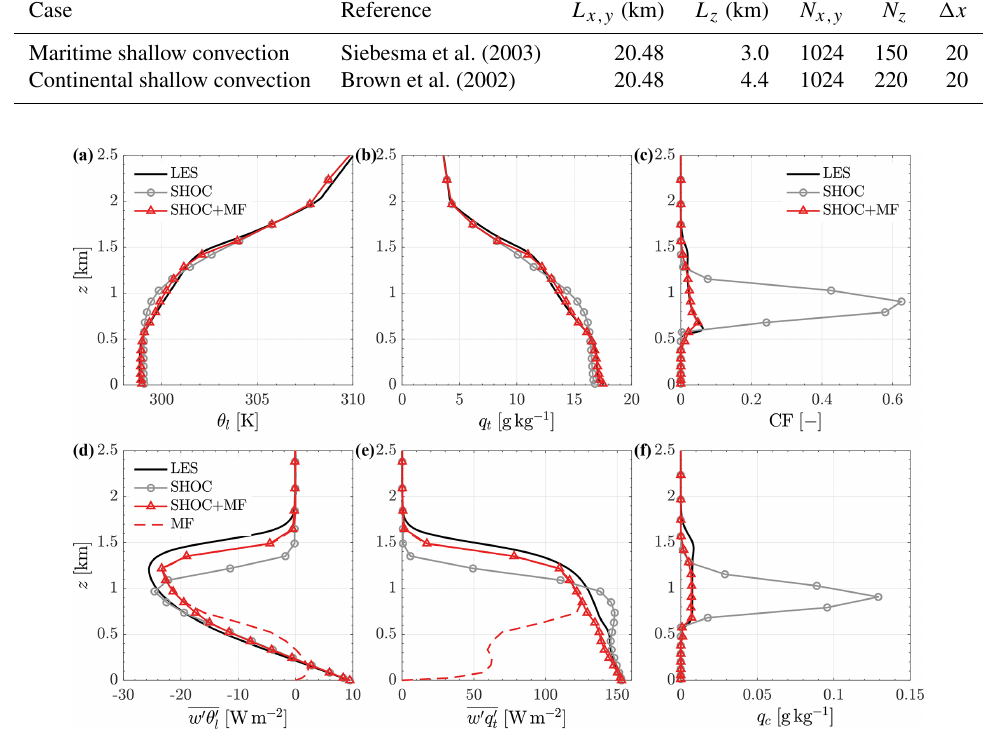
Figure 1. Vertical profiles of (a) liquid water potential temperature, (b) total water mixing ratio, (c) cloud fraction, (d) turbulent heat flux, (e) turbulent moisture flux, and (f) cloud water mixing ratio for LES (solid black line), SHOC (solid grey line), SHOC + MF (solid red line), and MF (dashed red line) for the BOMEX case. The profiles correspond to a time average over t = 4–6h. (e.g., Suselj et al., 2013; Kurowski et al., 2019b); i.e., the lo- cal mixing dominates in the subcloud layer, and MF takes over in the cloud